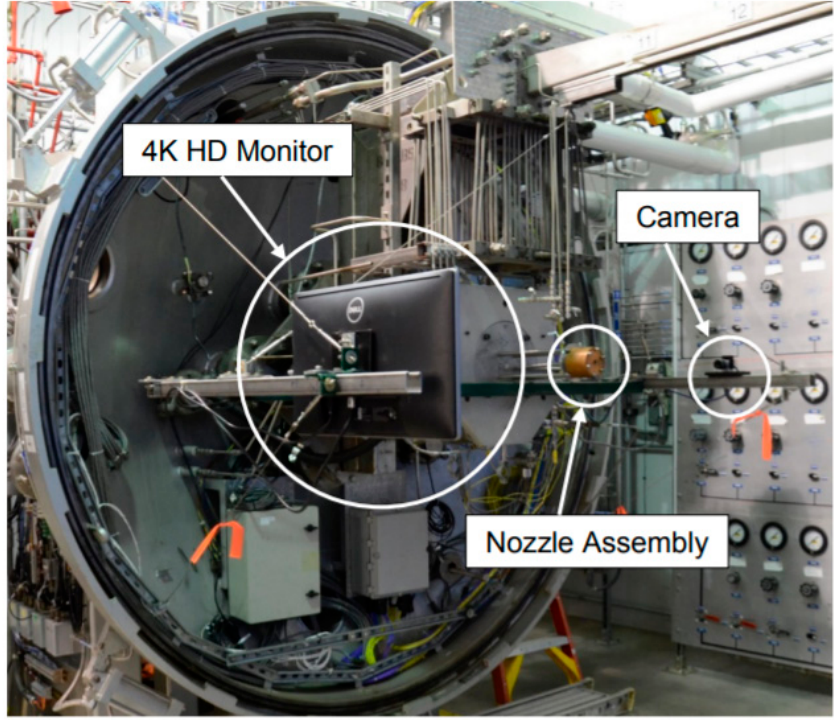
Figure 34. Theoretical/experimental data comparison for the rainbow Schlieren. Reprinted with permission from Ref. [46] (2017).